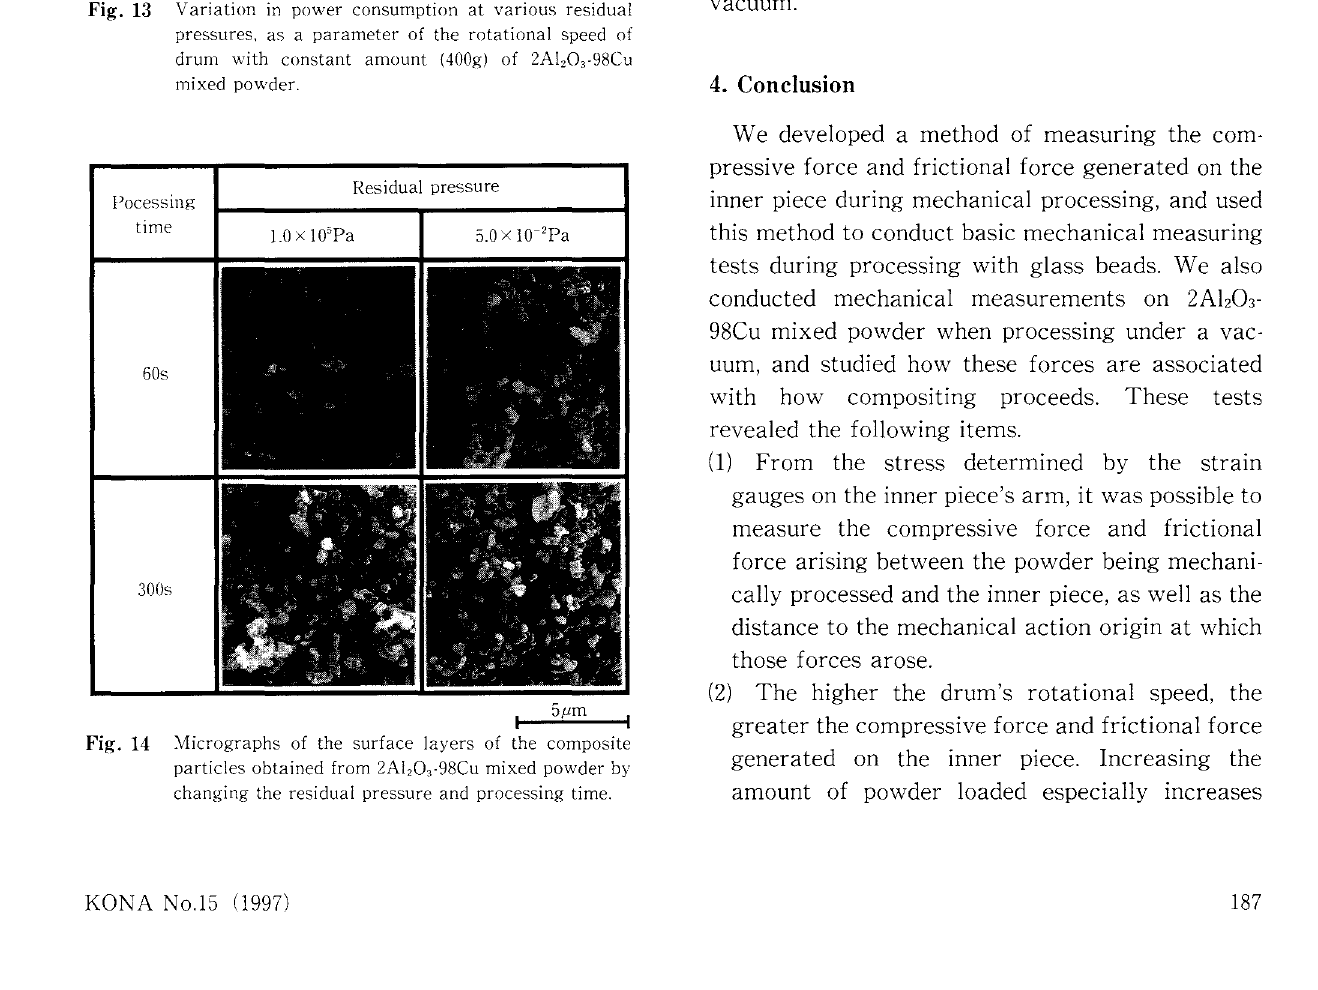
Fig. 14 :vlicrographs of the surface layers of the composite particles obtained from 2AI,0 ·98Cu mixed powder by 3 changing the residual pressure and processing